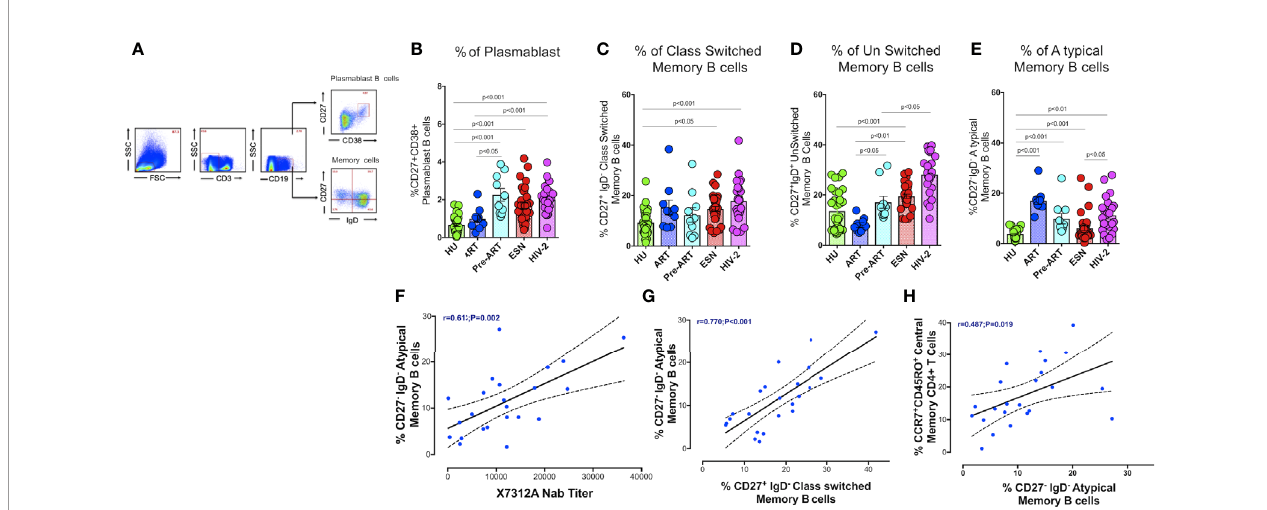
FIGURE 2 | Distribution of Memory B cells and Plasmablast B cells in the study groups. (A) Representative fl ow plots for enumeration of memory B cells and Plasmablast B cells (CD27+CD38+ expression on B cells) among the HU, HIV-1+ART+, HIV-1+ART-, HESN and HIV-2 groups. (B) Frequency of CD27+CD38+ Plasmablast B cells in the HU, HIV-1+ART+, HIV-1+ART-, HESN and HIV-2 groups. (C) Frequency of CD27+IgD- Class Switched Memory B cells in the HU, HIV-1+ ART+, HIV-1+ART-, HESN and HIV-2 groups. (D) Frequency of CD27-IgD- unswitched Memory B cells in HU, HIV-1+ART+, HIV-1+ART-, HESN and HIV-2 groups. (E) Frequency of CD27+IgD+ Atypical Memory B cells in HU, HIV-1+ART+, HIV-1+ART-, HESN and HIV-2 groups. The scatter dot plots summarize the % frequency of total memory B cells and Plasmablast cells (median, 1st and 3rd quartiles). P values were calculated using the K-Wallis test. Sub-group analysis was performed using Dunn ’ s test. (F) Correlation between frequency of CD27-IgD- Atypical Memory B cells and X7312A neutralizing antibody titers in HIV-2 infected individuals. (G) Correlation between frequency of CD27-IgD- Atypical memory B cells and frequency of CD27+IgD- Class Switched Memory B cells in HIV-2 infected individuals. (H) Correlation between frequency of CCR7+ CD45RO+ Central Memory CD4 + T cells and frequency of CD27-IgD- Atypical Memory B cells in HIV-2 infected individuals. (HU, HIV unexposed seronegative controls, HIV-1+ART+: HIV-1-infected women on ART; HIV-1+ART-: HIV-1-infected women naïve to ART; HESN: HIV exposed seronegative individuals; HIV-2: HIV-2 infected